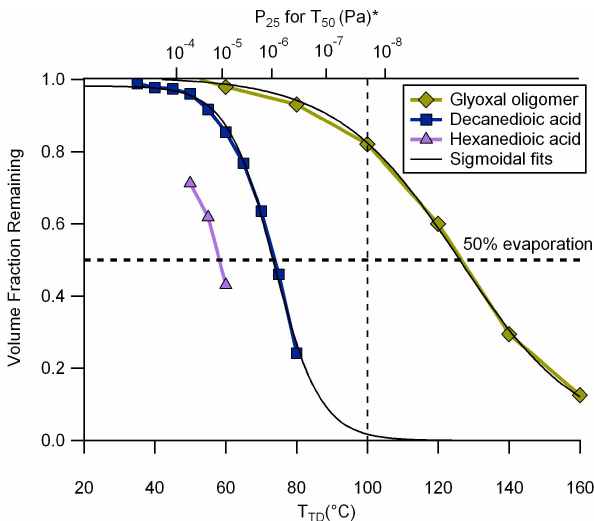
Fig. 1. Thermograms of hexanedioic acid, decanedioic acid, and glyoxal oligomer (produced from evaporating droplets of gly- oxal/water solution) where T TD is the set temperature of the ther- modenuder and P 25 is the vapor pressure of a compound at 25 ◦ ( ∗ calibration taken from Faulhaber et al.,